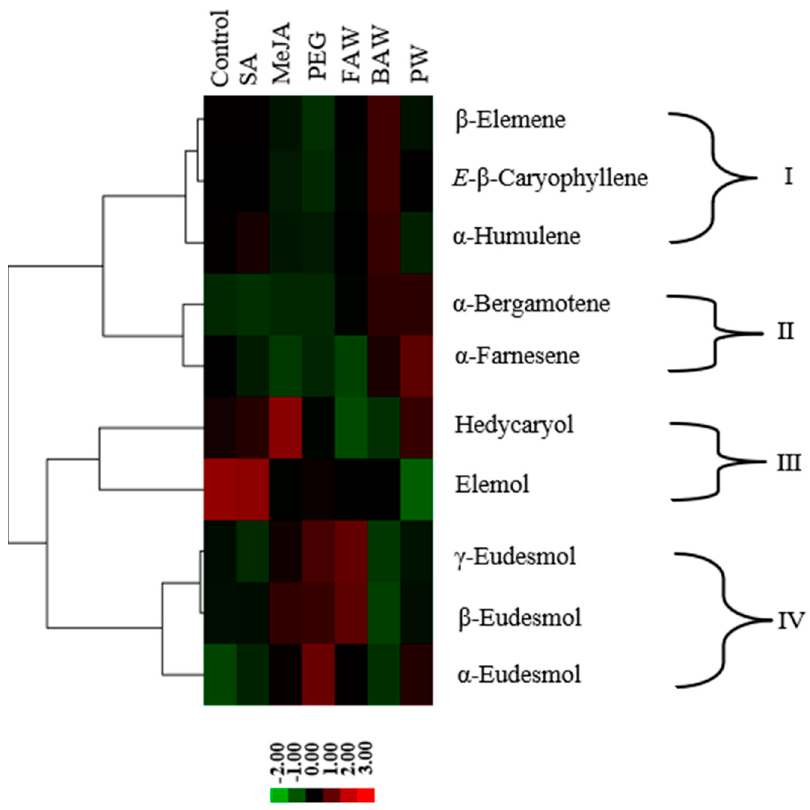
Figure 5. Cluster analysis of sesquiterpenoids. Hierarchical cluster analysis was performed based on the concentration of chemicals from leaves of C. iria under seven conditions, including control, SA, MeJA, PEG, PW, FAW and BAW, respectively. Sesquiterpenoids were grouped into four clades (clade I–IV).